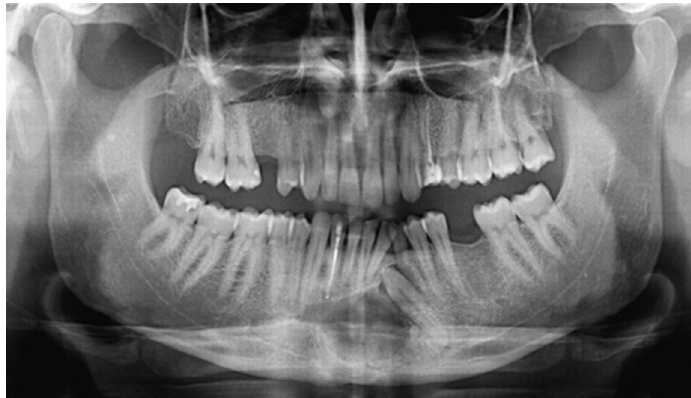
Figure 1. During a routine orthopantomography (2007) performed 10 years before PIOSCC diagnosis, an impacted left lower canine, and a related incidental radiolucent cystic lesion was detected, compatible with the diagnosis of a dentigerous cyst.